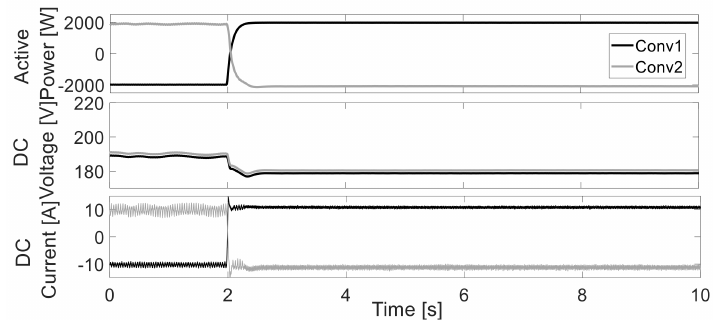
Figure 8. Experimental results of power reversal from − 2000 W to 2000 W with Conv1 in power control and Conv2 using I vs. V dc droop.